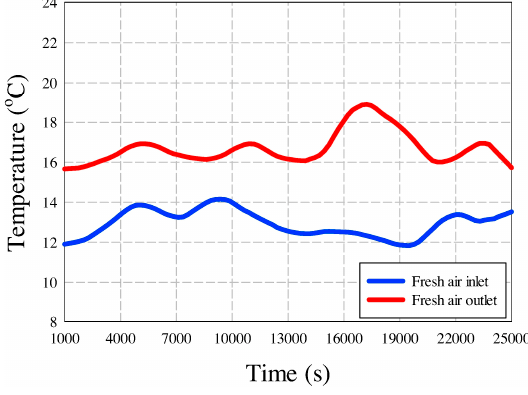
Figure 14 . Temperature monitoring during testing [47]. Figure 14. Temperature monitoring during testing